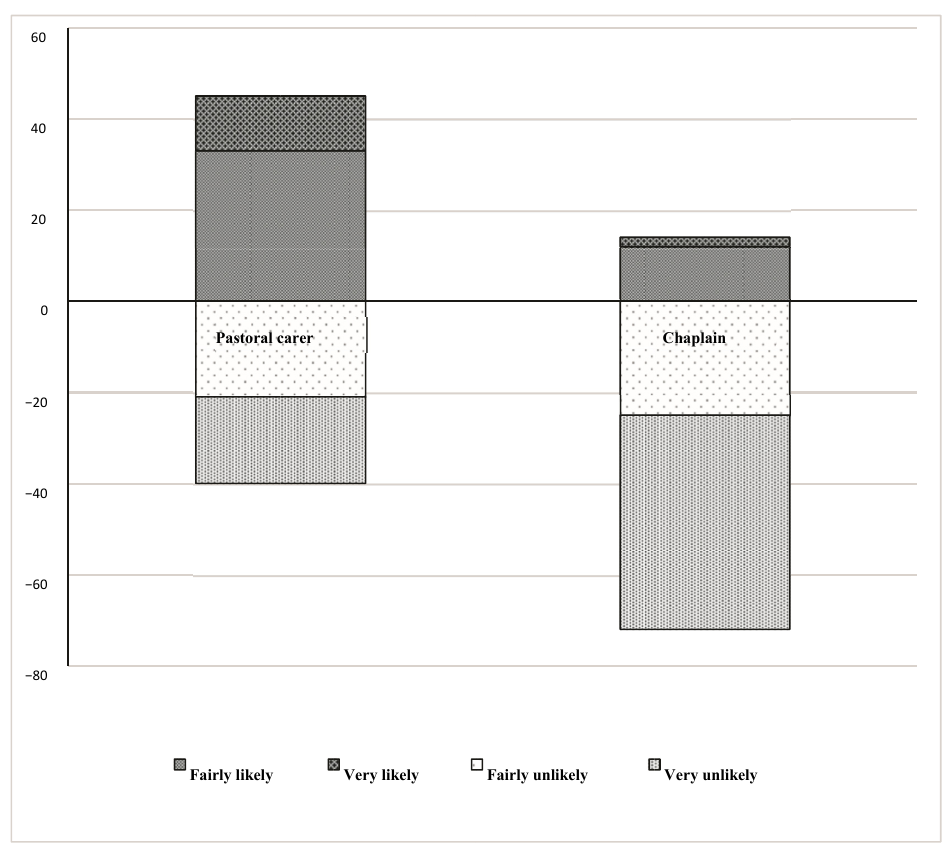
Figure 3. Likelihood of accessing care, non-religious respondents.